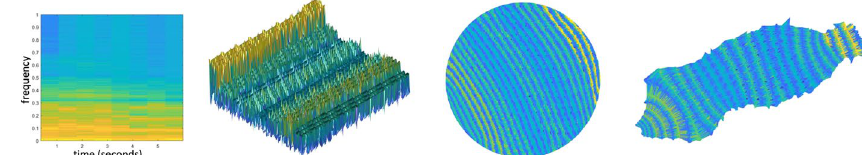
Fig. 3 Visualization of the process of measuring distortions associated with the parametrization problem. The figure depicts, from left to right: a sound spectrogram, a triangular mesh ( V , ℑ ) representation of the spectrogram surface, an initial mapping of ( V , ℑ ) onto the plane and the final flattening of the mesh, computed by means of the ABCD